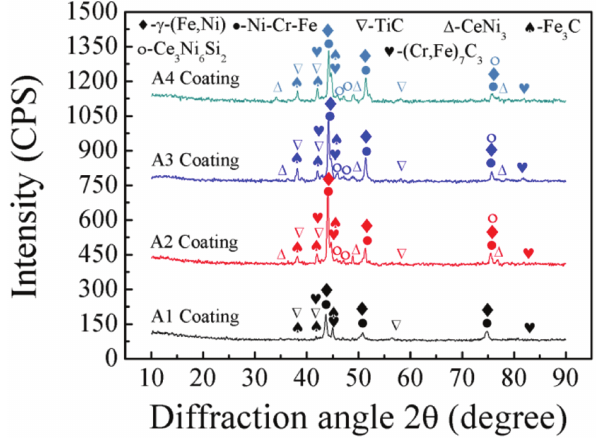
Figure 4: XRD patterns of the composite coatings before wear test.